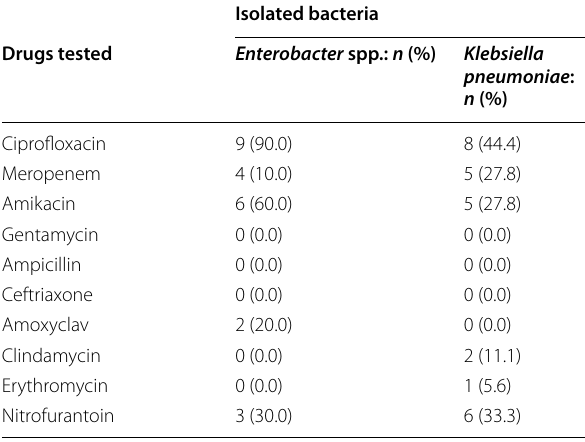
Table 2 Antibiotics sensitivity patterns among neonates with urinary tract infection ( N =